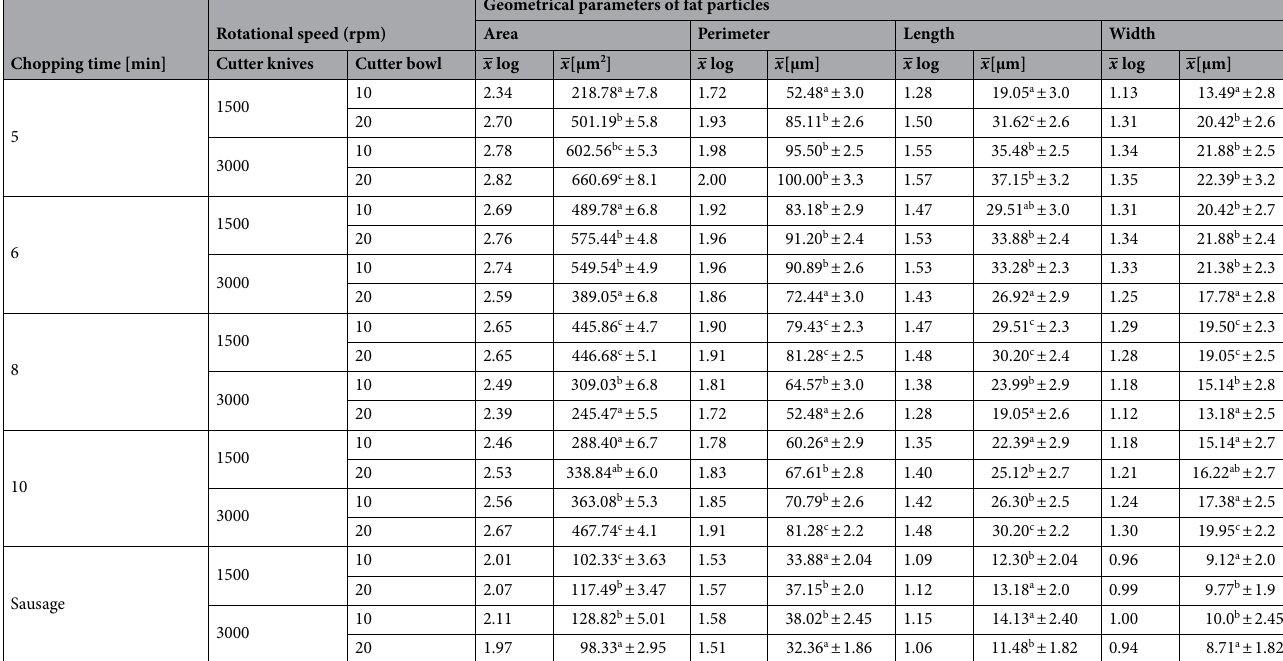
Table 1. The characteristics of the geometrical parameters of fat particles vs the rotational speed of the cutter knives and bowl (1500/10 rpm, 1500/20 rpm, 3000/10 rpm, 3000/20